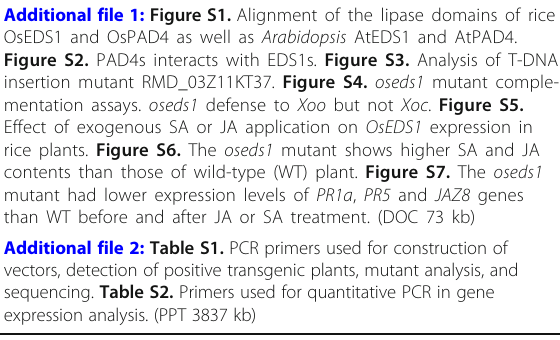
Figure S2. PAD4s interacts with EDS1s. Figure S3. Analysis of T-DNA insertion mutant RMD_03Z11KT37. Figure S4. oseds1 mutant comple- mentation assays. oseds1 defense to Xoo but not Xoc . Figure S5. Effect of exogenous SA or JA application on OsEDS1 expression in rice plants. Figure S6. The oseds1 mutant shows higher SA and JA contents than those of wild-type (WT) plant. Figure S7. The oseds1 mutant had lower expression levels of PR1a , PR5 and JAZ8 genes than WT before and after JA or SA treatment. (DOC 73